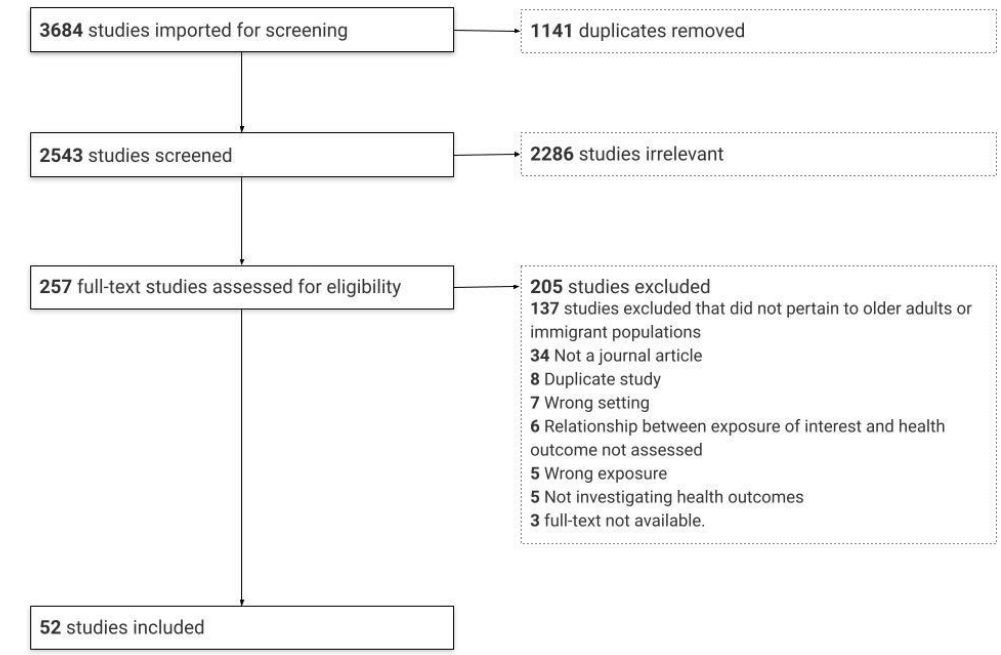
Figure 1. Flow diagram of the study selection process.